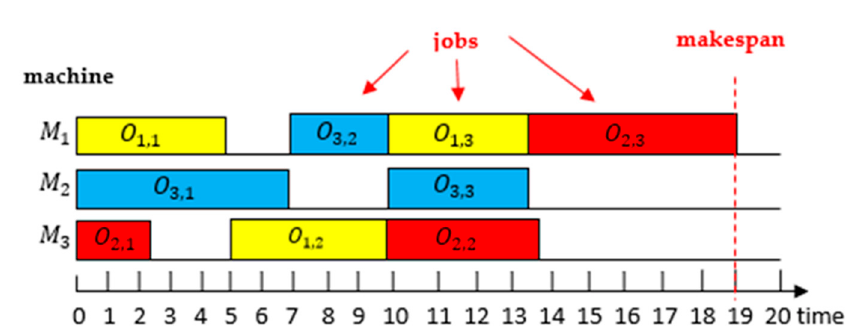
Figure 2. Gantt chart of solutions.